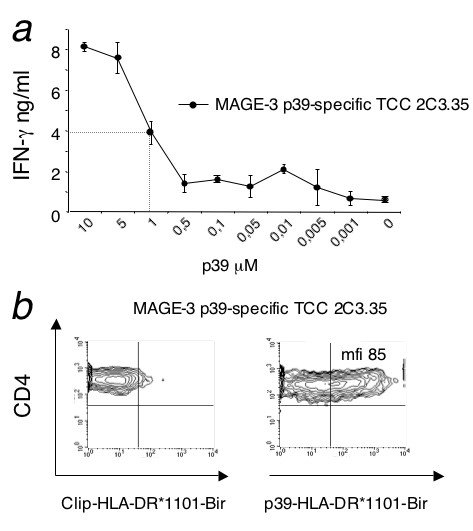
HLA-DR*1101-Bir tetramers stain CD4+ T cells specific for the MAGE-3 tumour antigen derived p39 epitope. Ability of p39-loaded HLA-DR*1101-Bir tetramers to stain a specific CD4+ TCC. (a) Clone M3 2C3.35 was assayed for IFN-γ production to different doses of p39 peptide. 104 T cells are incubated for 48 hours with 5 × 104 HLA-DR*1101+ LCL cells and the indicated doses of p39 peptide. IFN-γ in the supernatant is measured by ELISA. (b) Staining of a MAGE-3-specific T cell clone. The cells are stained at day 19 from re-stimulation with 10 μg of either CLIP-loaded or p39-loaded HLA-DR*1101-Bir tetramers for 2 hours at 37°C.